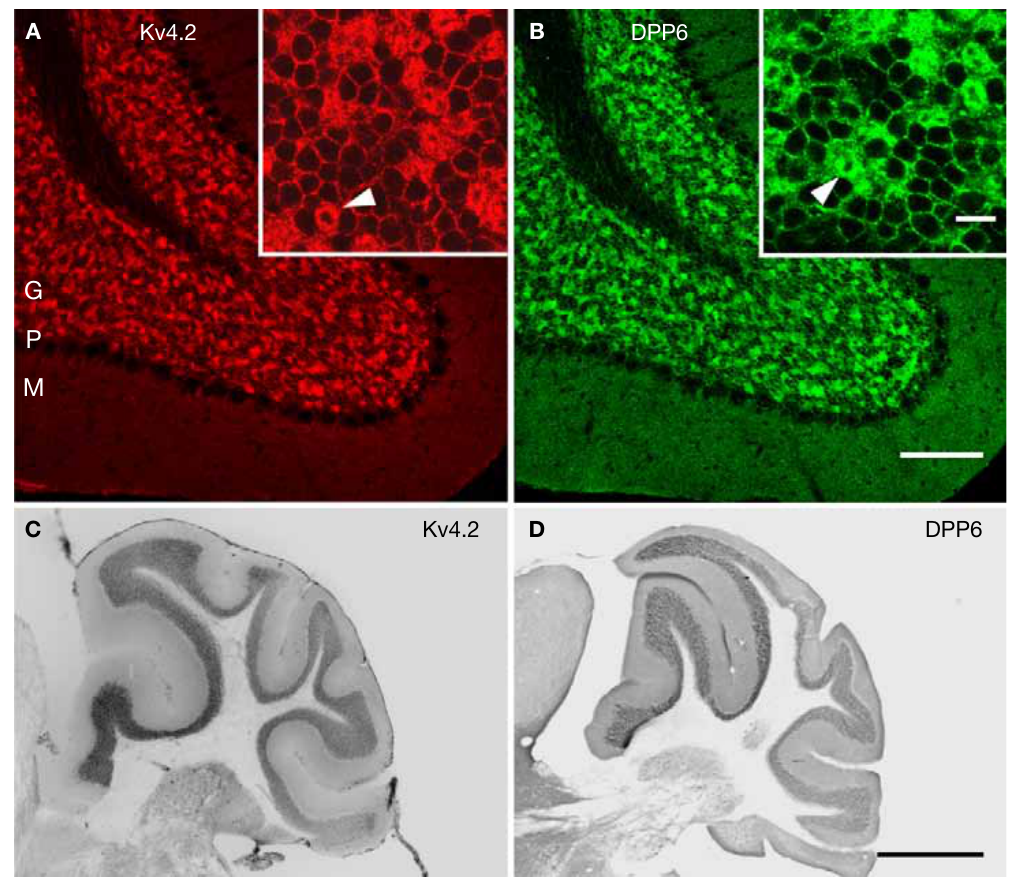
Figure 7 | Immunolocalization of Kv4.2 and DPP6 proteins in the cerebellar cortex. Confocal fl uorescent images of the cerebellar cortex single labeled with antibodies to Kv4.2 ( A , pseudocolored red) or DPP6 ( B , pseudocolored green). Immunostaining for both Kv4.2 and DPP6 is prominent in the granule cell layer (G), while the molecular layer (M) is weakly stained in both instances. Also, neither antibody labeled Purkinje cells (P). The insets show high magnifi cations of the granule cell layer demonstrating high density labeling of the cerebellar glomeruli (arrowheads). Granule cell somata are more weakly stained, and the label is restricted to the periphery of the cell. Scale bars: 100 μ m for main panels in (A) and (B) ; 10 μ m for the insets in (A) and (B) . (C,D) Immunoperoxidase staining showing anterior-posterior gradient of expression of Kv4.2 and DPP6 proteins in the granule cell layer in lateral cerebellar lobules. Shown are sagittal sections of the mouse cerebellum immunostained with antibodies to Kv4.2 (C) or DPP6 (D) . Immunolabeling for both, Kv4.2 and DPP6, is more prominent in anterior than posterior lobules. Scale bar: 1 mm for (C) and (D)